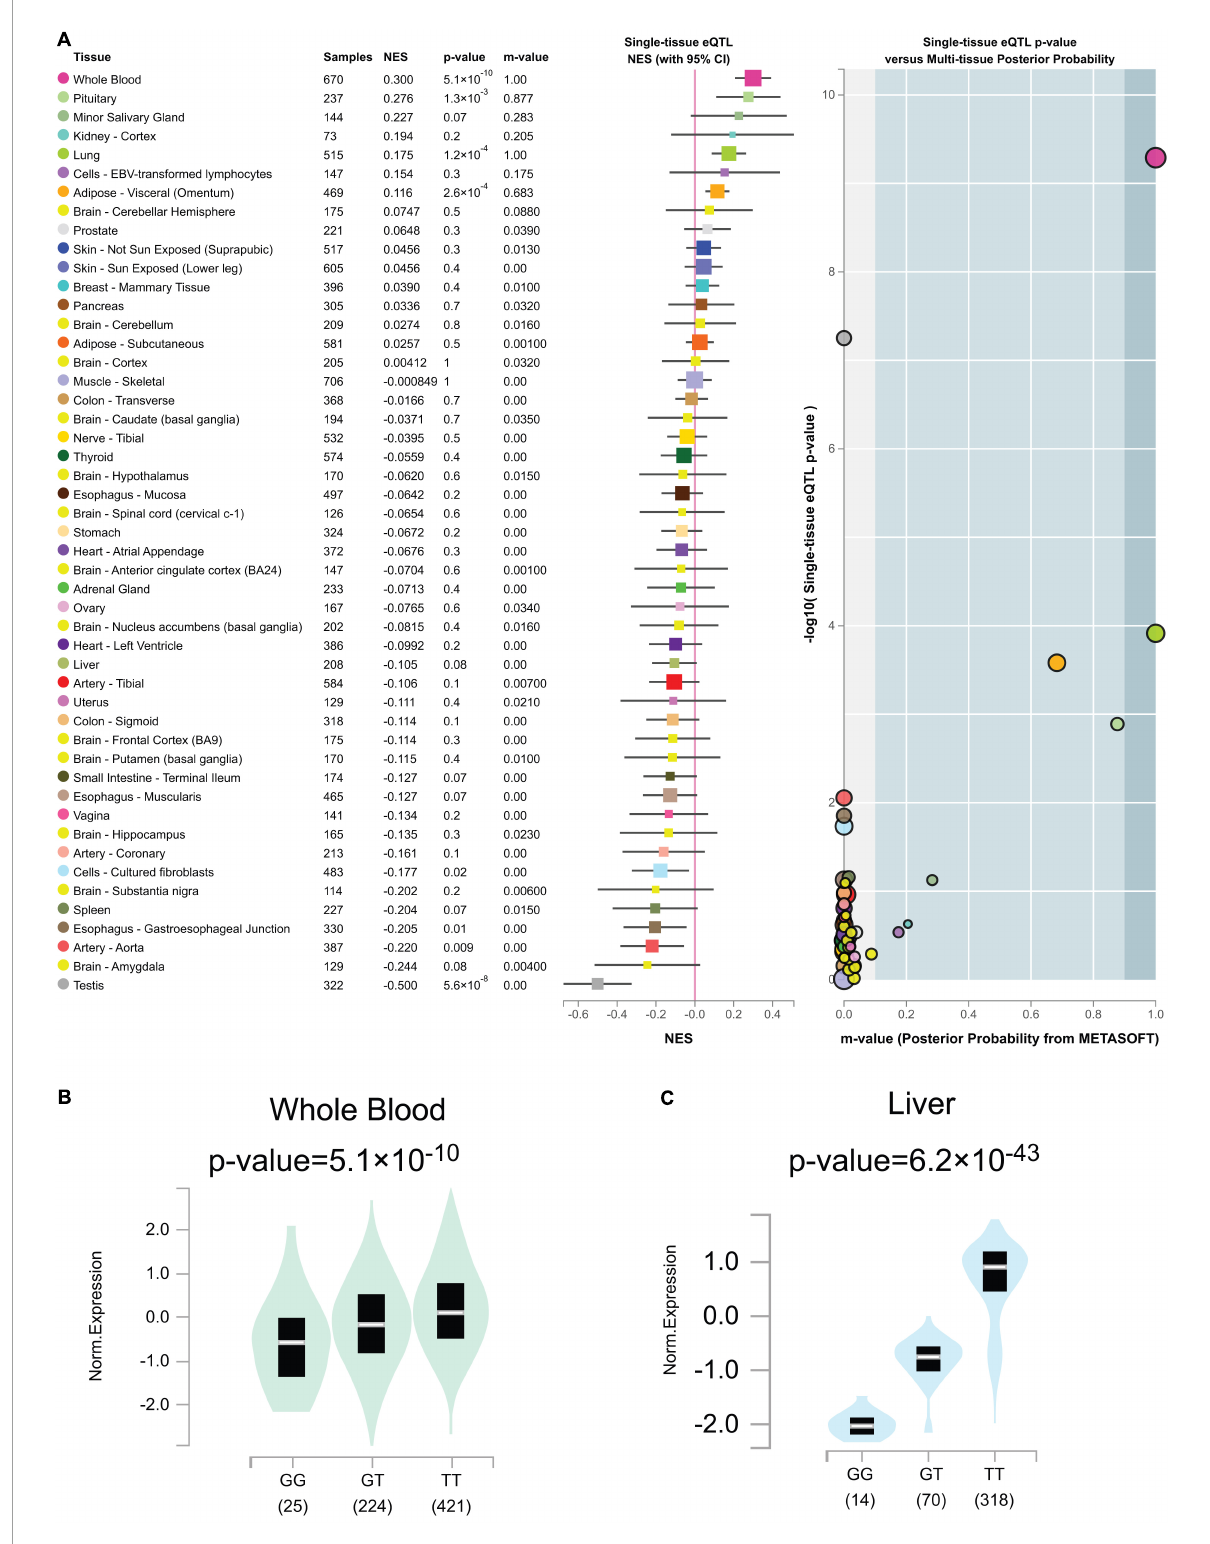
FIGURE7 (A) Genotype cis -expression quantitative trait loci analysis for rs2244613 in 49 human tissues was obtained from the GTE database. (B) Violin plots of allele-specific cis -eQTLs according to rs2244613 genotypes in whole blood tissue in the Genotype-Tissue Expression (GTEx) dataset. (C) Violin plots of allele-specific splicing quantitative trait loci (sQTL) according to rs2244613 genotypes in liver tissue in the GTEx